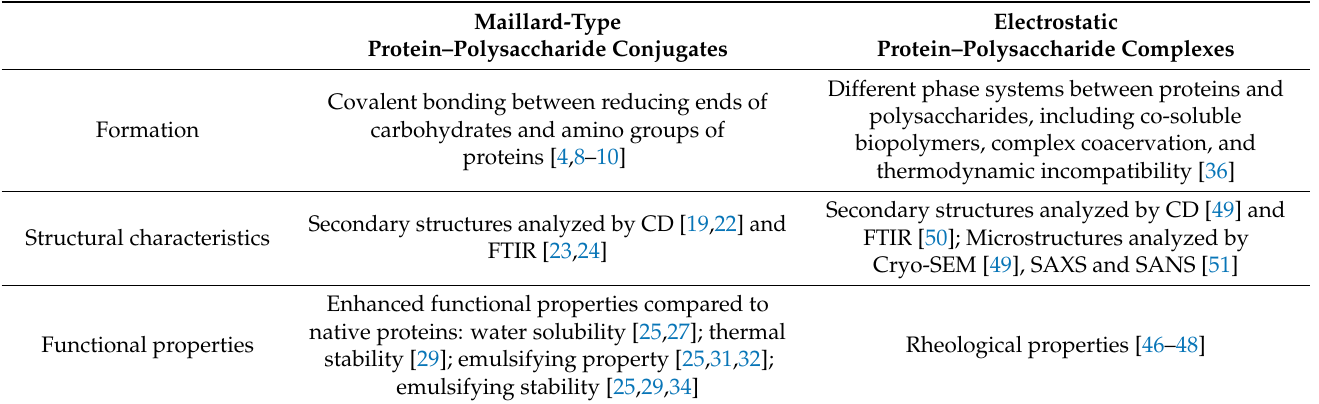
Table 1. Comparison between Maillard-type protein–polysaccharide conjugates and electrostatic